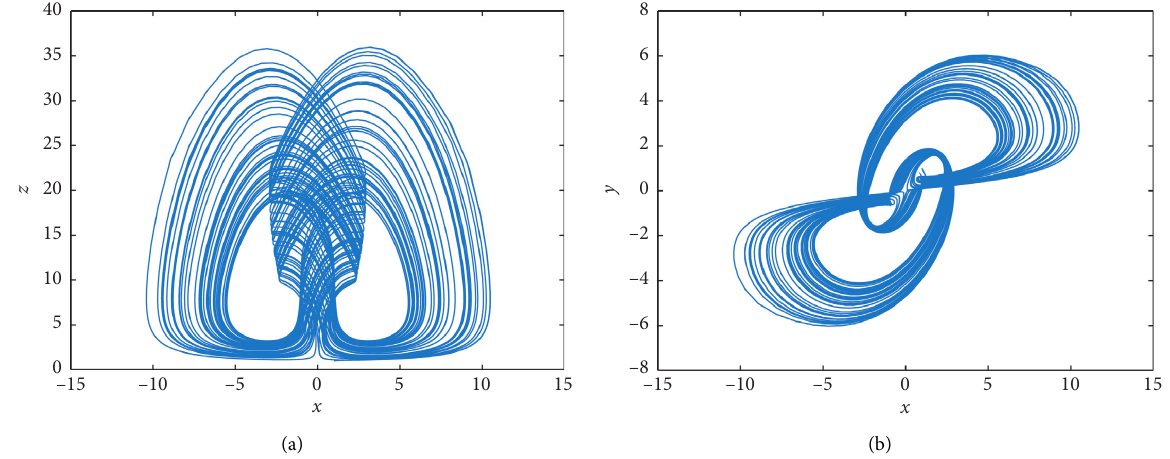
Figure 14: Phase portraits of the fractional system with b � 9 . 5 and α � 0 . 95.